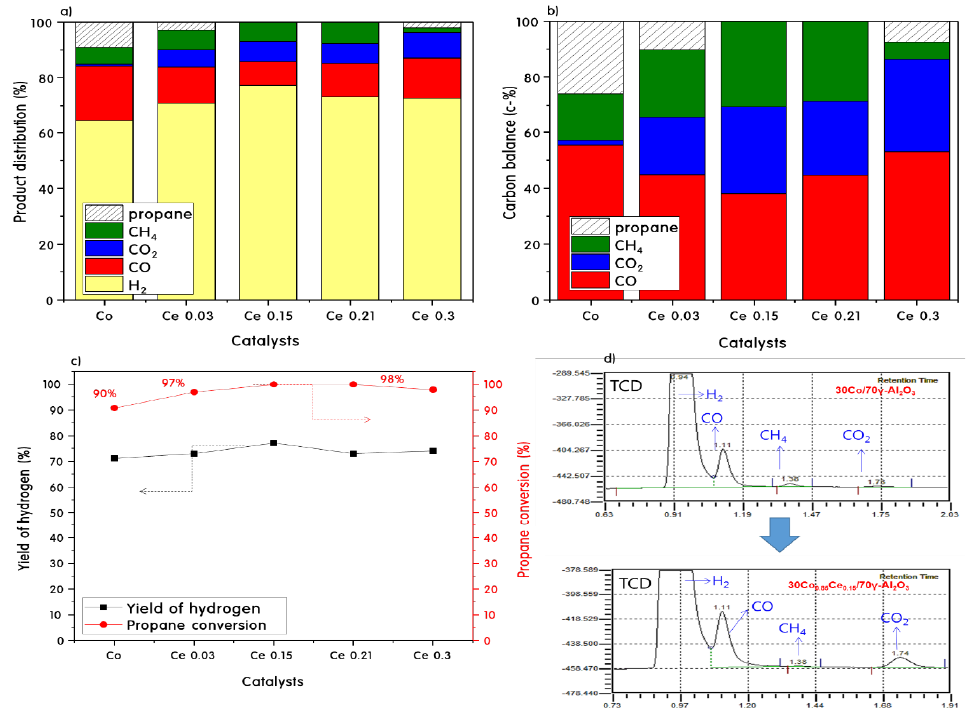
Figure 7. Product distributions ( a , b ) and hydrogen yield and propane conversion ( c ) during propane steam reforming reaction at 700 °C after 10 h and GC signals ( d ).